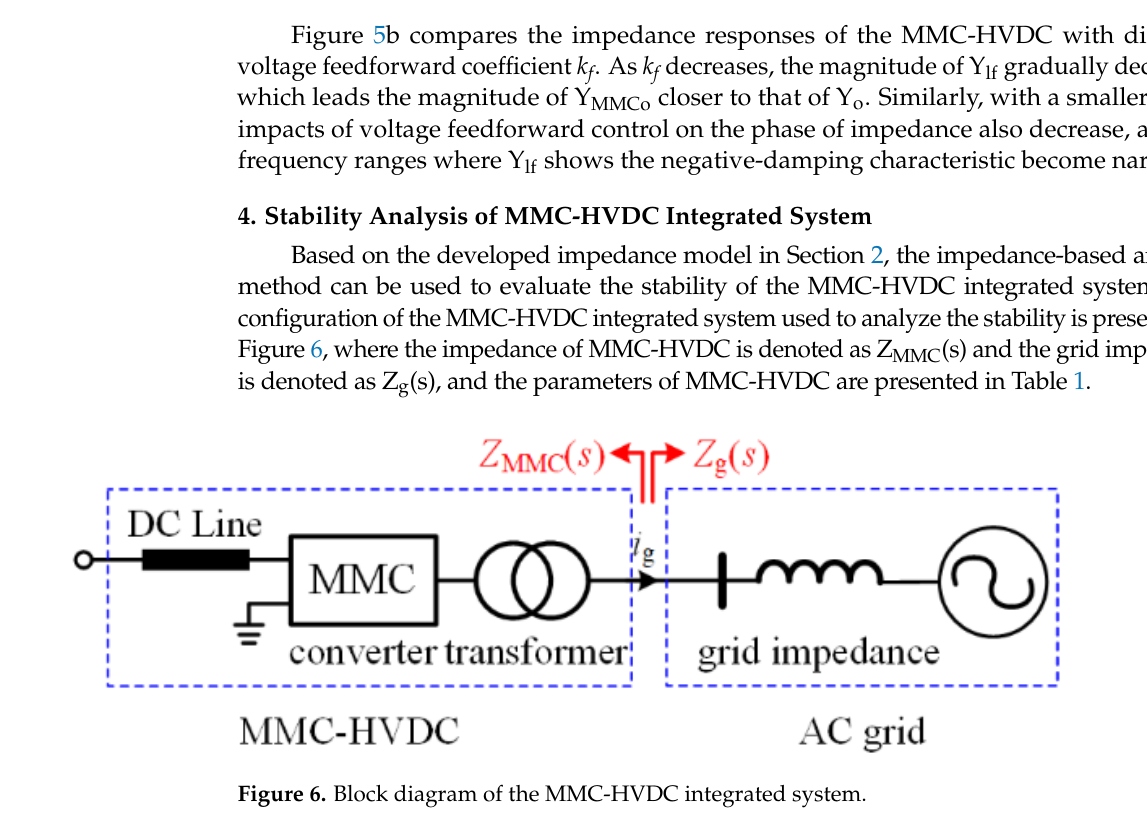
Figure 5. Impacts of voltage feedforward control on admittance characteristics of MMC-HVDC (VFC stands for voltage feedforward control). ( a ) comparison of MMC-HVDC impedance charac- teristic w/wo voltage feedforward control. ( b ) impacts of voltage feedforward control parameters on MMC-HVDC impedance characteristic.